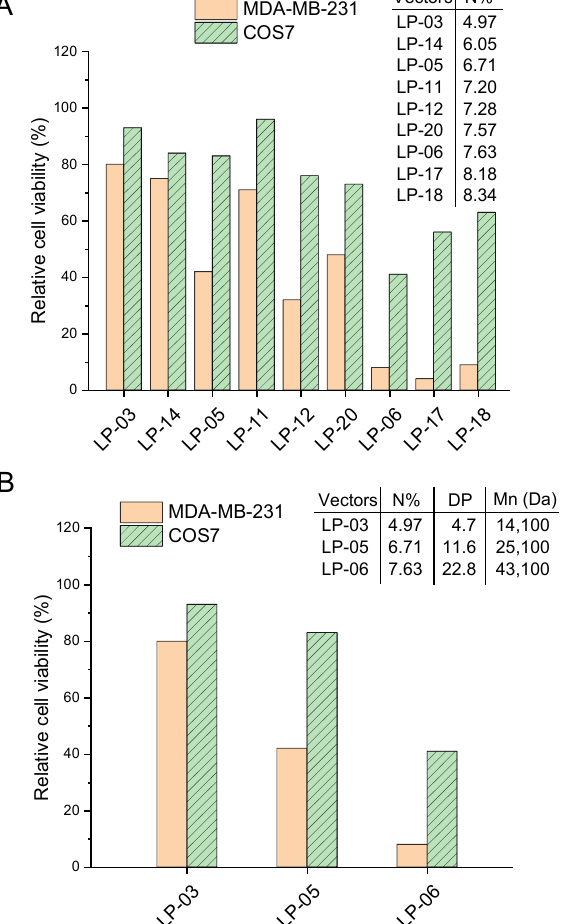
Figure 8. ( A ) Variation of the relative cell viability with the N content of the lignin-PDMAEMA copolymers in MDA-MB-231 and COS7 cell lines at the copolymer concentration of 25 µg/mL. ( B ) Variations of the relative cell viability with the degree of polymerization (DP) and molecular weight (Mn) for the selected lignin-PDMAEMA copolymers LP-03, 05 and 06 in MDA-MB-231 and COS7 cell lines at the copolymer concentration of 25 µg/mL. Data for LP-14 was reported previously [18]. However, for copolymers obtained from same lignin initiator, their cytotoxicity was usually determined by PDMAEMA arm length only. In such cases, both the N% and mo- lecular weight of copolymer were proportional to the PDMAEMA arm length. The